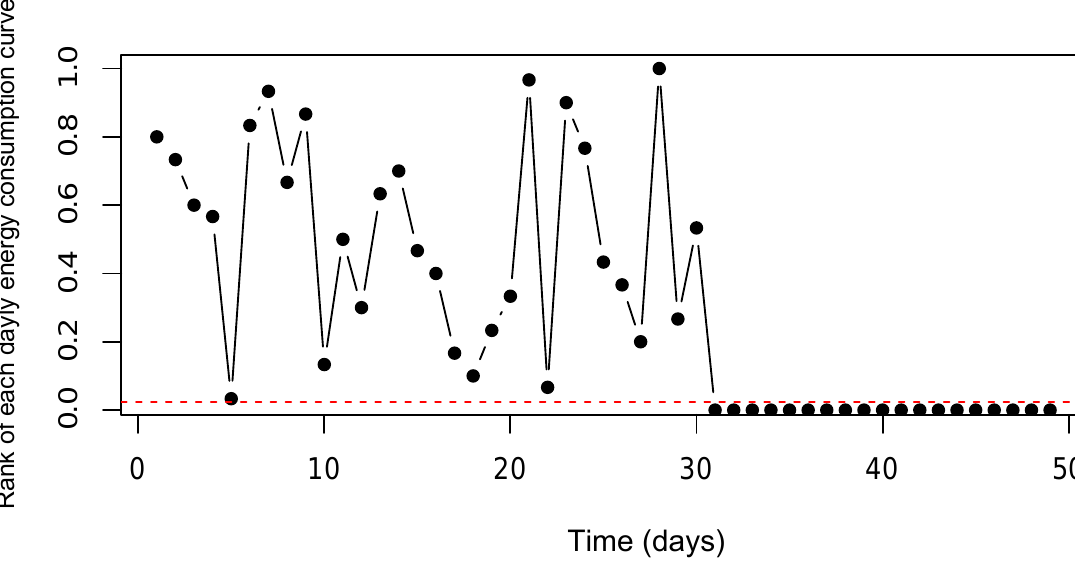
Figure 8. Rank control chart for Phase II of quality control. Both reference (corresponding to August and September) and monitoring (corresponding to November) samples are